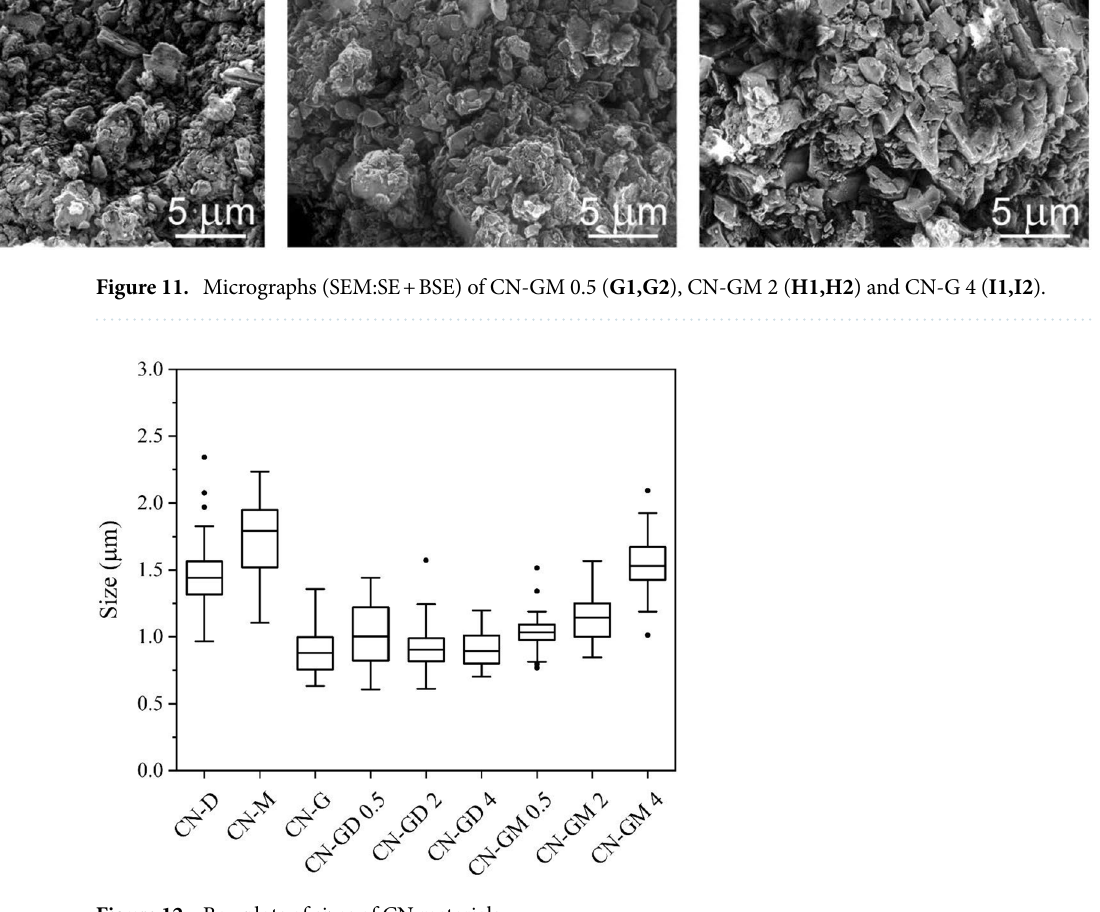
Figure 12. Box plots of sizes of CN